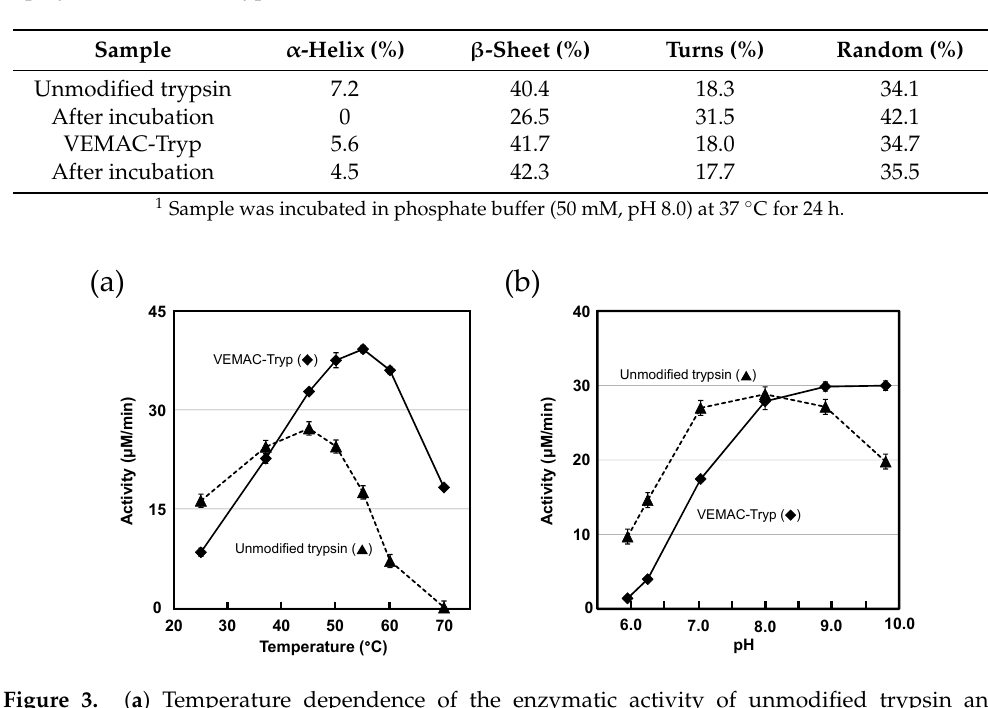
Table 3. Secondary structure contents of unmodified trypsin and vinylmethylether-maleic acid